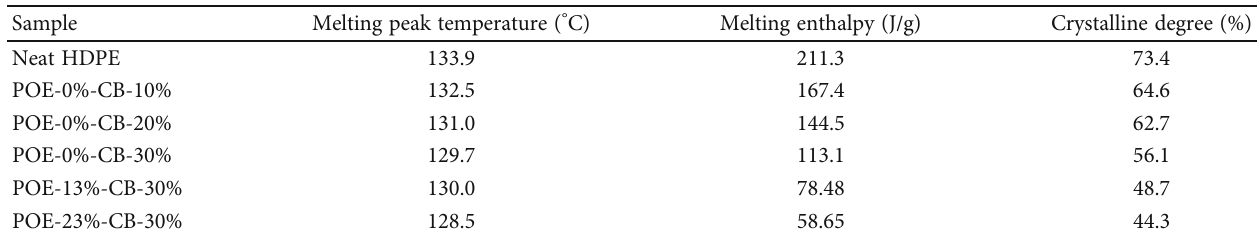
Table 2: Thermal behavior of HDPE/POE/CB composites with various CB content and POE content. Sample